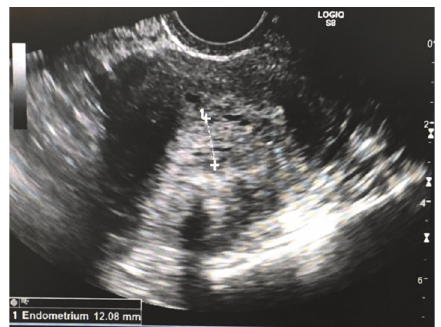
Figure 1: Ultrasound imaging of uterus demonstrating a 12.1mm endometrial stripe.